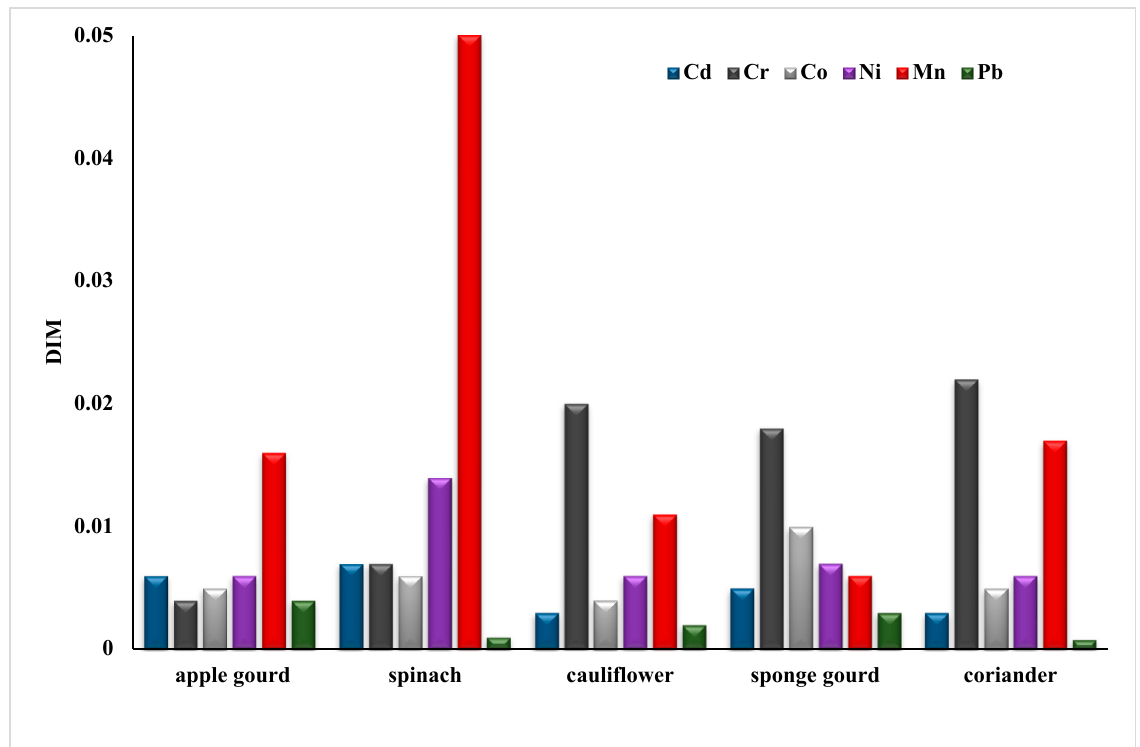
Figure 2. Daily intake of heavy metals in vegetables. Table 3. Calculated Health Risk Index found for the different study vegetables.